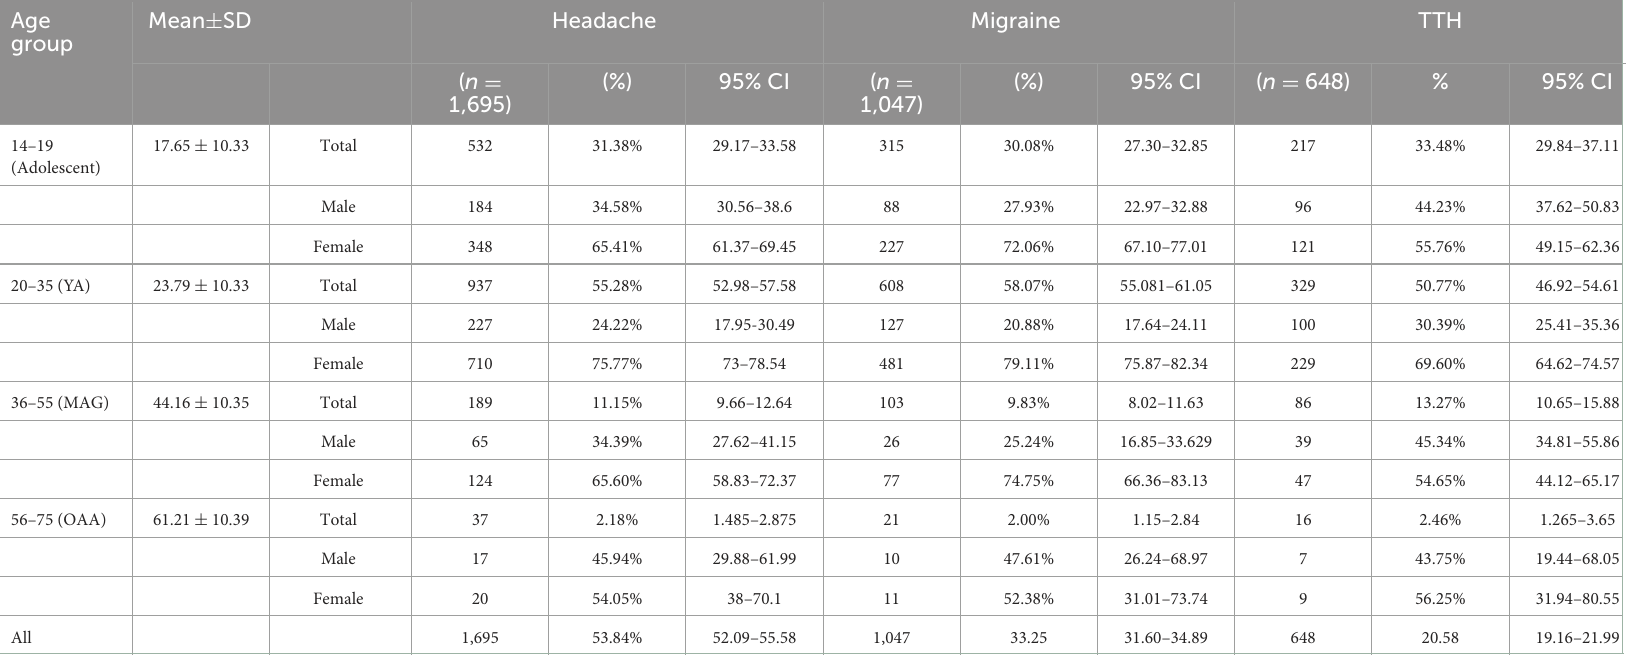
TABLE 4 One-year prevalence of headache and its type adjusted for age and